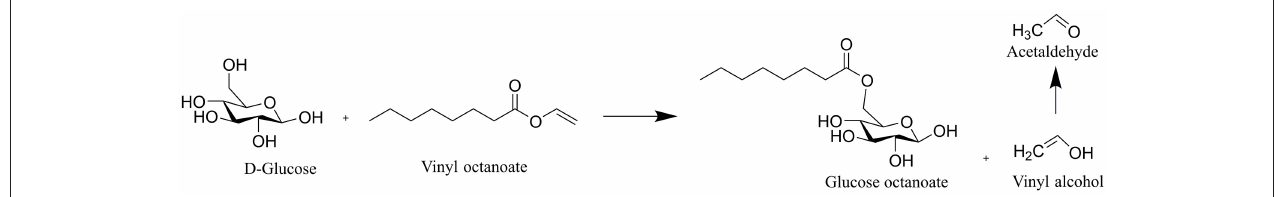
FIGURE 2 | Lipase-catalyzed esterification between glucose and vinyl octanoate leads to the formation of glucose-octanoate and ethanol. The vinyl alcohol tautomerizes to acetaldehyde and evaporates, which prevents the back reaction. The same scheme applies to fructose and other fatty acid vinyl